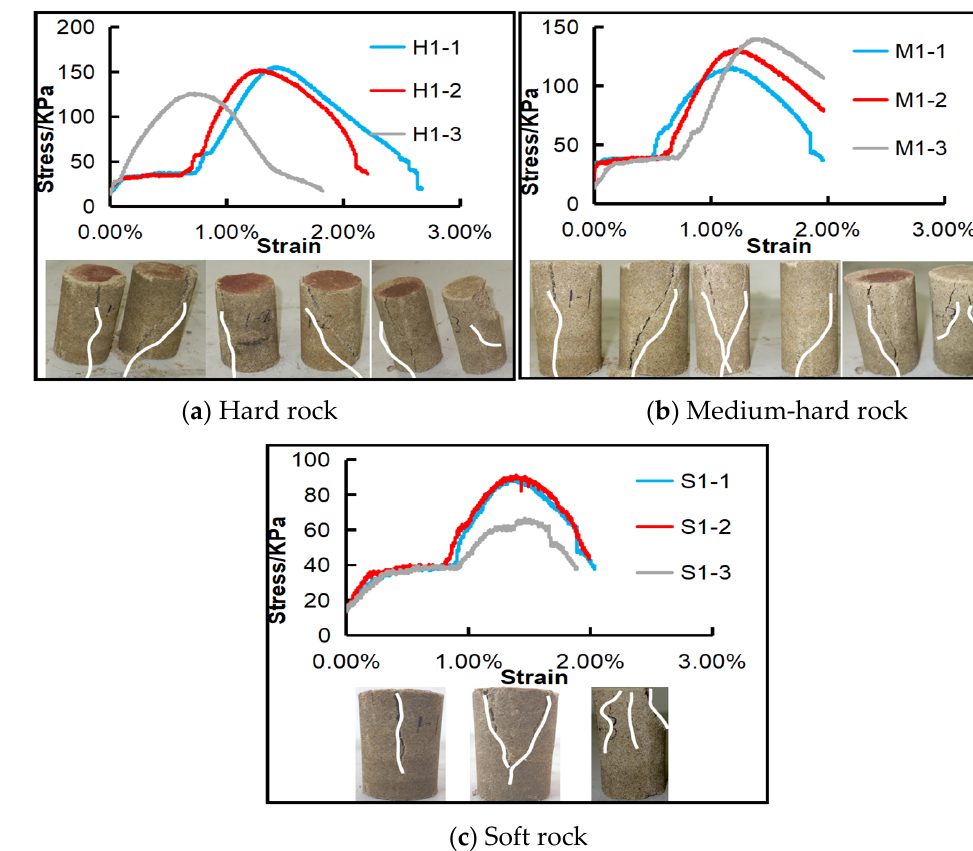
Figure 2. Stress–strain curves of specimens in different groups.